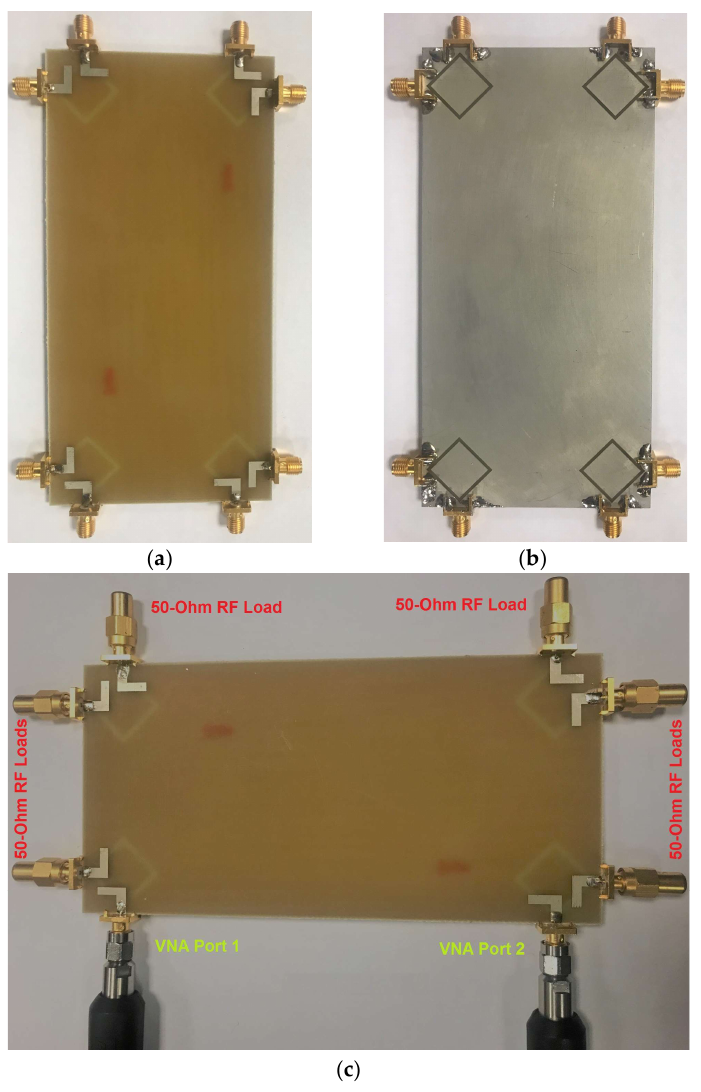
Figure 15. As illustrated, the diamond-ring slot resonators achieve good S parameters with sufficient impedance bandwidth and low mutual coupling characteristic in the desired frequency range. Some deviations from the measurements arise from the errors in fabrication, feeding and experiment Figure 13. E ffi ciencies of the antenna elements (Ant. 1–Ant. 8) for the proposed design. processes. Figure 13. Efficiencies of the antenna elements (Ant. 1–Ant. 8) for the proposed design.